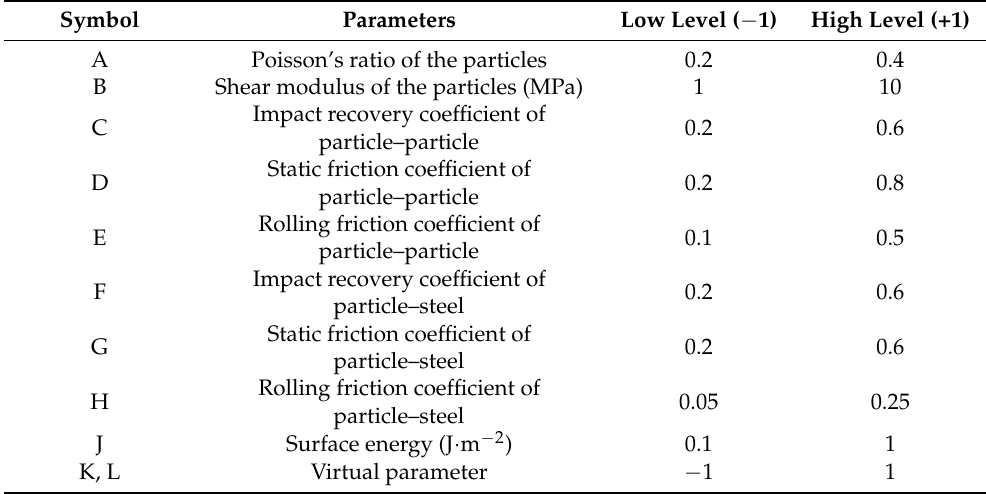
Table 1. The parameter table of the Plackett–Burman